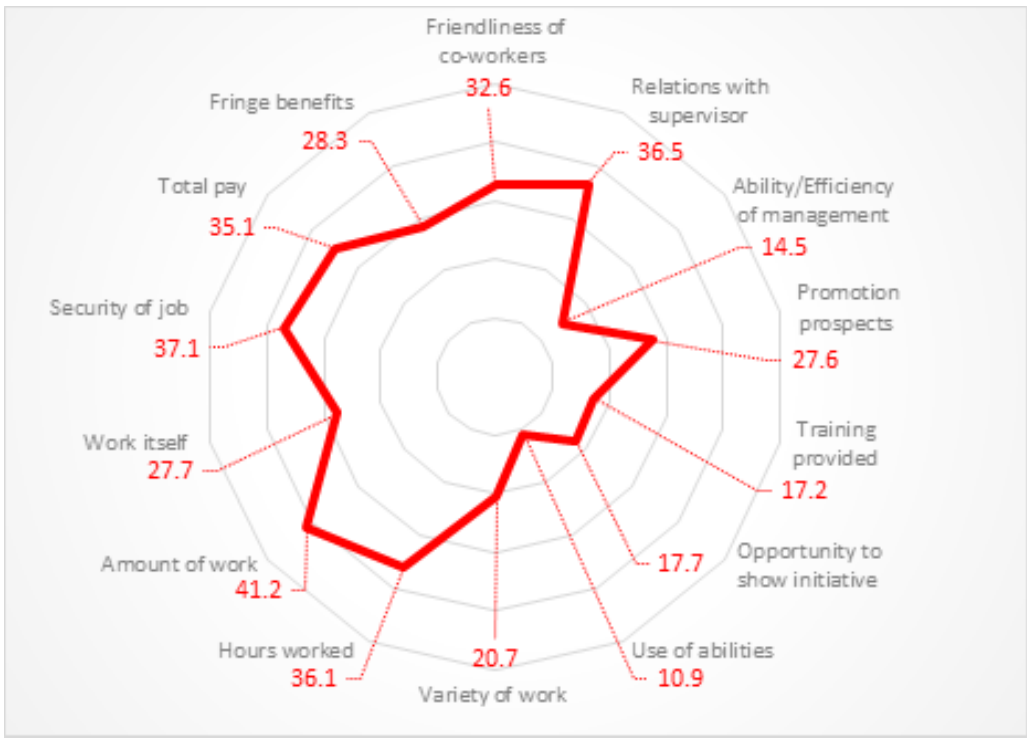
Figure 3. Employee job satisfaction — weighted values between nominal satisfaction and motivational prioritization (1 – 100-point scale).